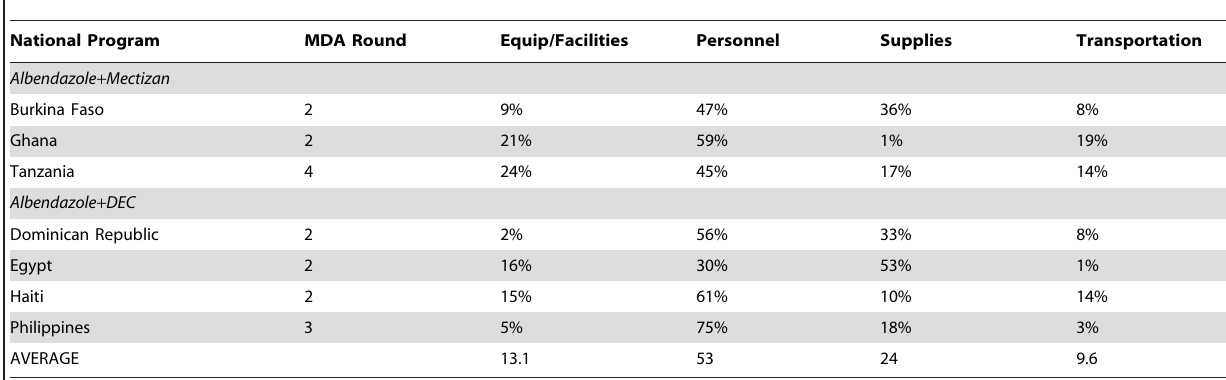
Table 6. Costs by Input – Percentage of Financial Costs for a ‘Non-Start-Up’ MDA Round.